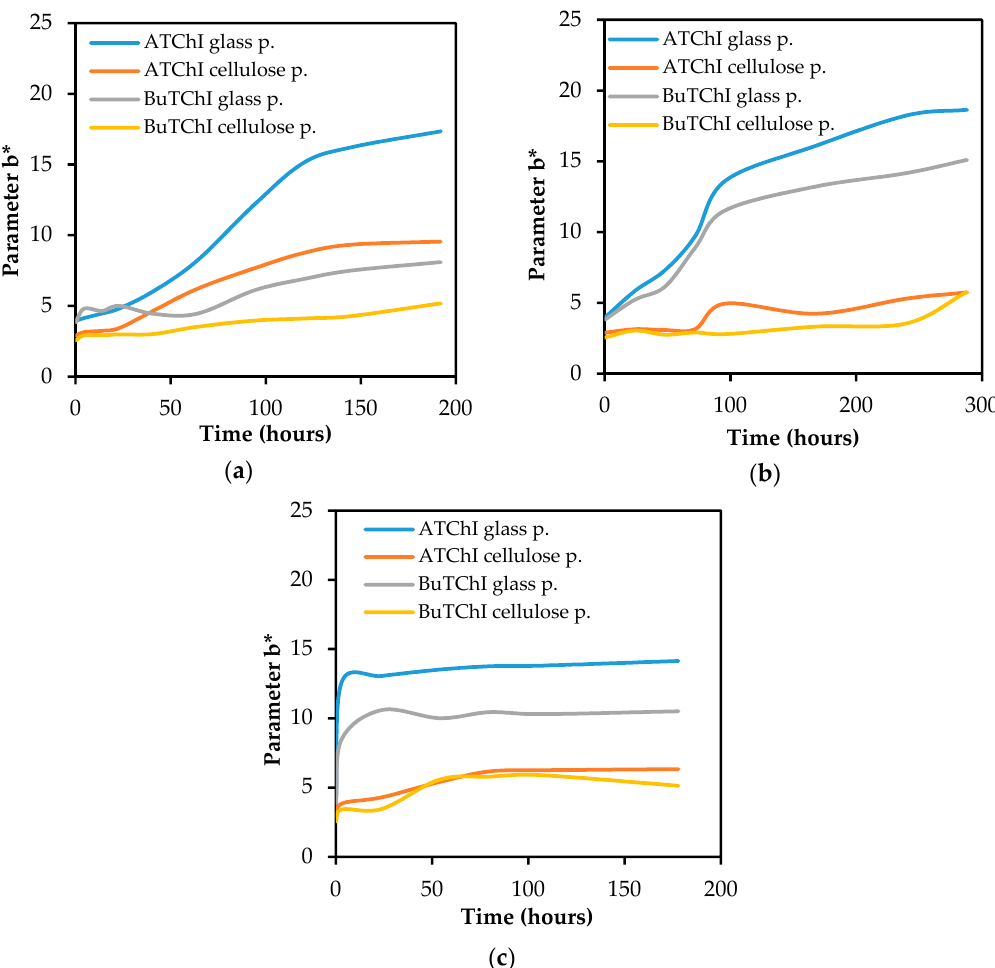
Figure 9. The stability of the substrate and Ellman’s reagent on a carrier: ( a ) in a dryer at 60 °C in a hermetically sealed glass container; ( b ) in the open air and light at room temperature; ( c ) loosely stored in a dryer at 60 °C. Biosensors 2018 , 8 , x